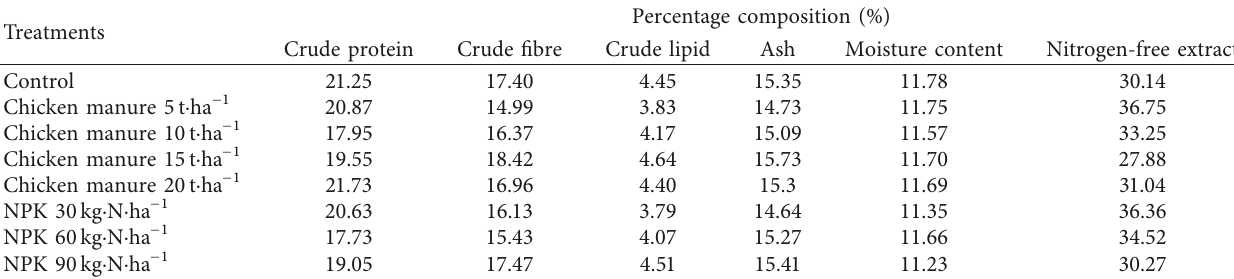
Table 8: Effect of different rates of chicken manure and NPK fertilizers on plant nutrient uptake by sunflowers. Treatments